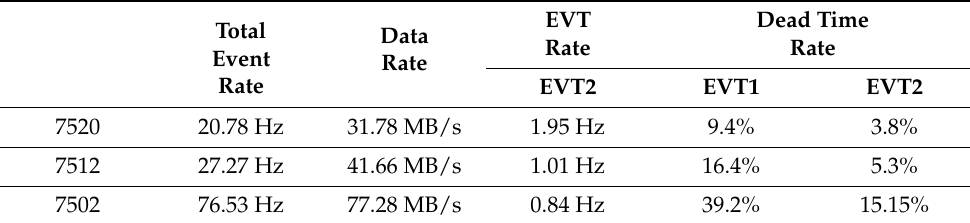
Table 2. Three run statistics with general configuration: Single Searching Mode, two type of S 2 events ( 83m Kr and beta decay events), 24 h, buffer priority for beta decay events, at least 2 PMT hits in a Coincidence Window of 1.2 µ s, data compression applied.